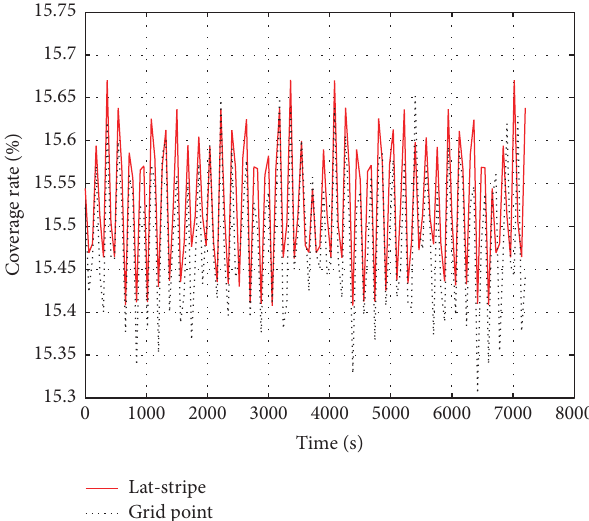
Figure 4: The variation of coverage rate when division granularity is 5 ∘ .